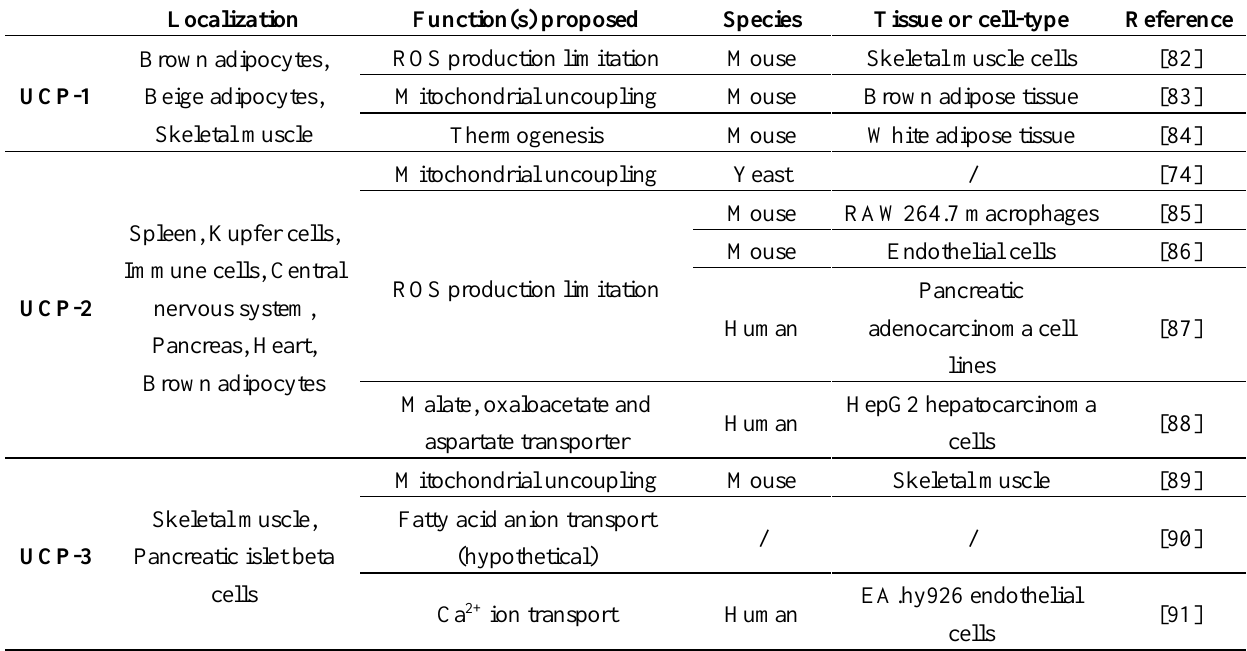
Table 1. Summary of localization and functions proposed for the different